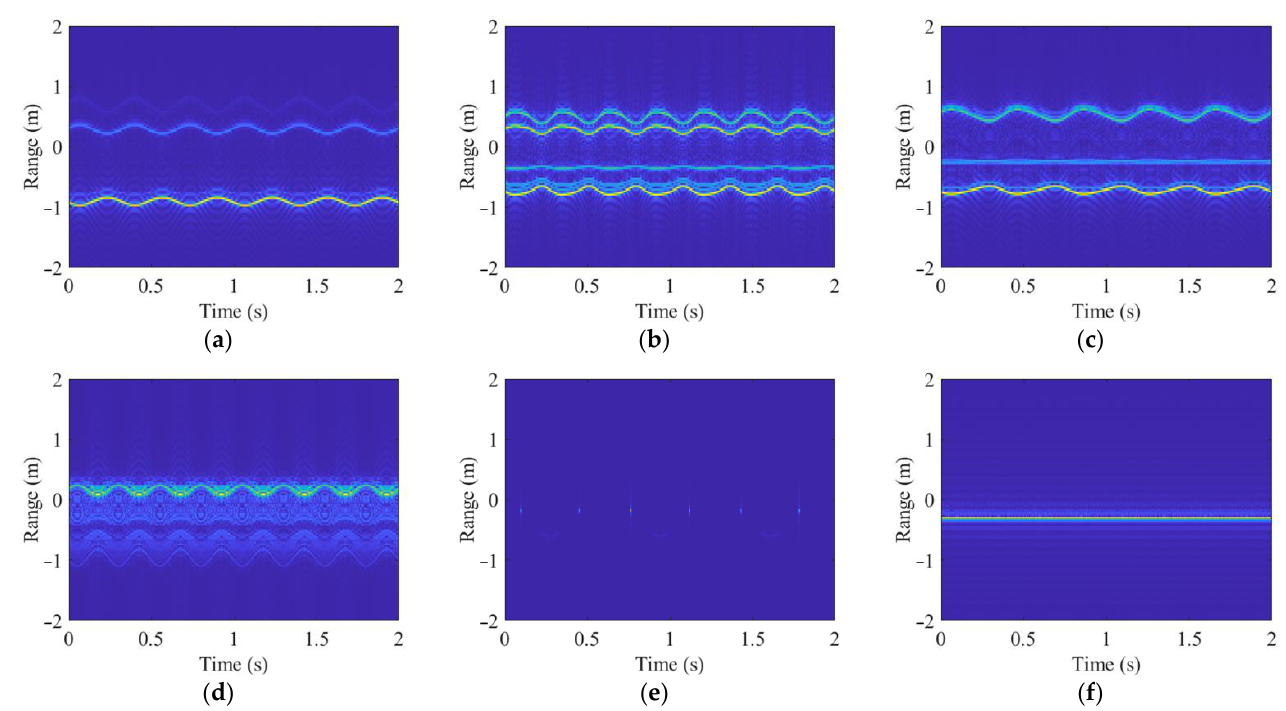
Figure 6. TR maps of the six targets. ( a ) Warhead 1; ( b ) warhead 2; ( c ) warhead 3; ( d ) decoy 1; ( e ) decoy 2; ( f ) decoy 3.